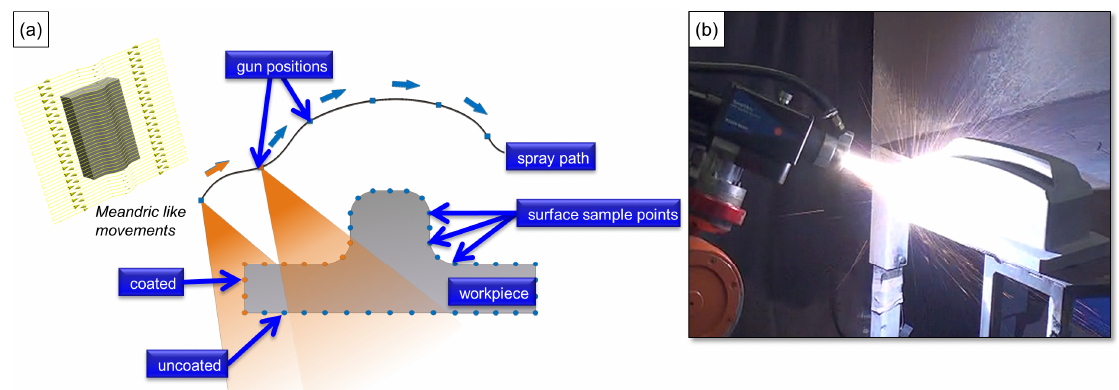
Figure 1. Spray path (schematic) on a simplified substrate geometry with outer and inner radii ( a ) and a TWAS process showing the coating deposition on a punch used for sheet metal forming ( b ).